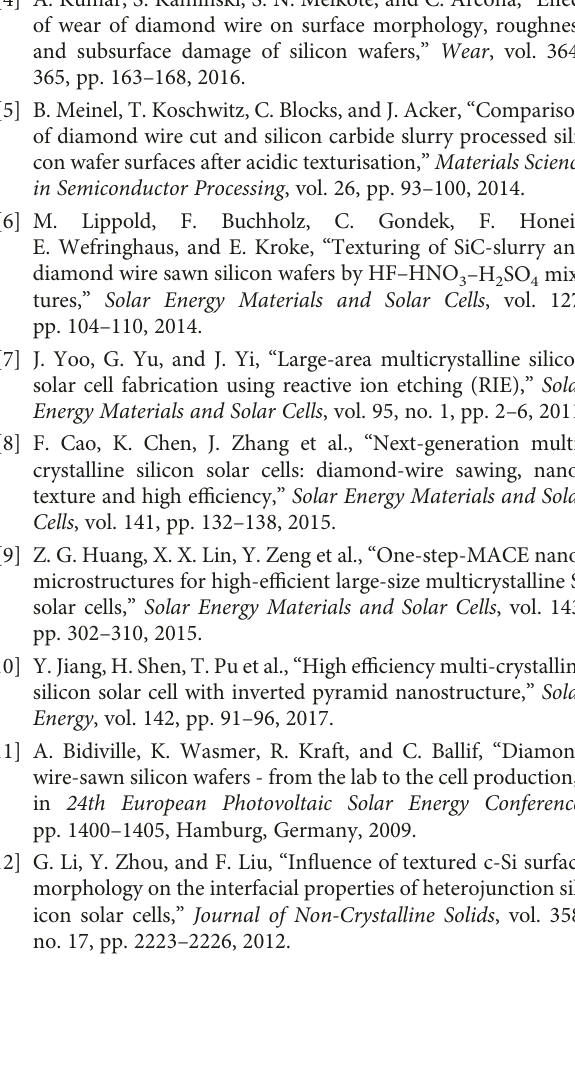
e ffi ciency and open-circuit voltage of RIE (19.05%) and MACE (18.86%) also demonstrate their potential to stream texturing process for DWS mc-Si solar cells.